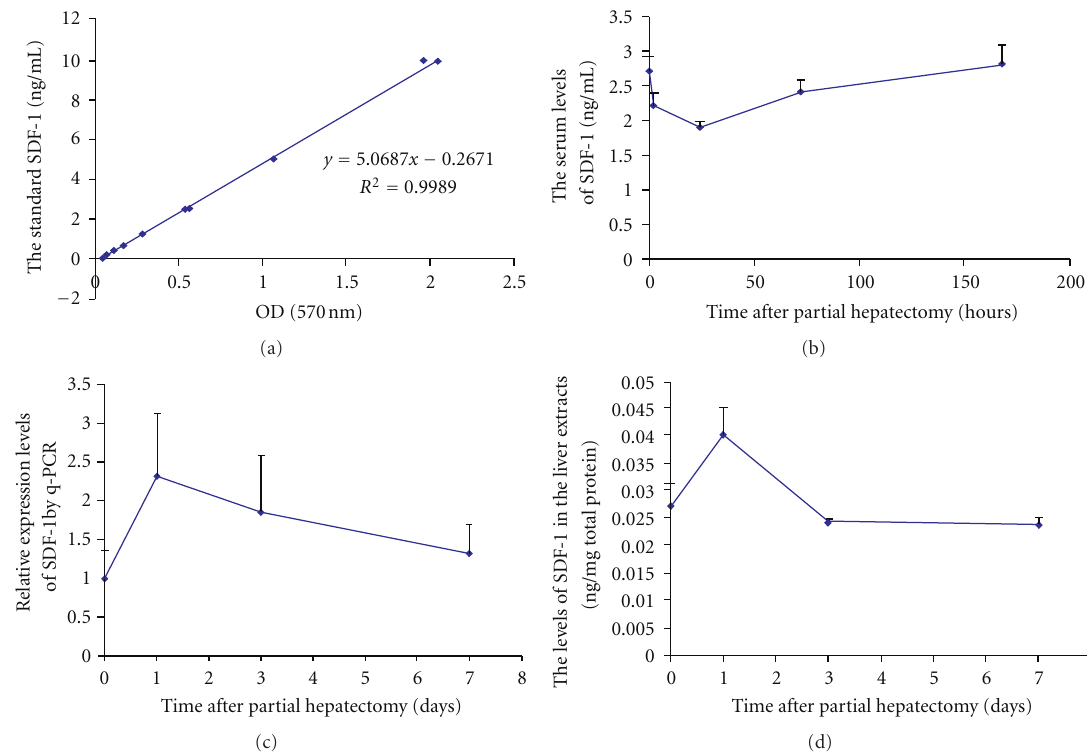
Figure 6: The levels of SDF-1 in the liver or the serum after partial hepatectomy. Serum samples (b) or liver extracts (d) were obtained from the mice at the di ff erent time points after partial hepatectomy, and analyzed to determine the levels of SDF-1 using ELISA ( n = 3–5). The levels of SDF-1 were calculated based on the standard curve (a). RT-PCR was performed to examine the mRNA level of SDF-1 in the hepatectomized livers (c).